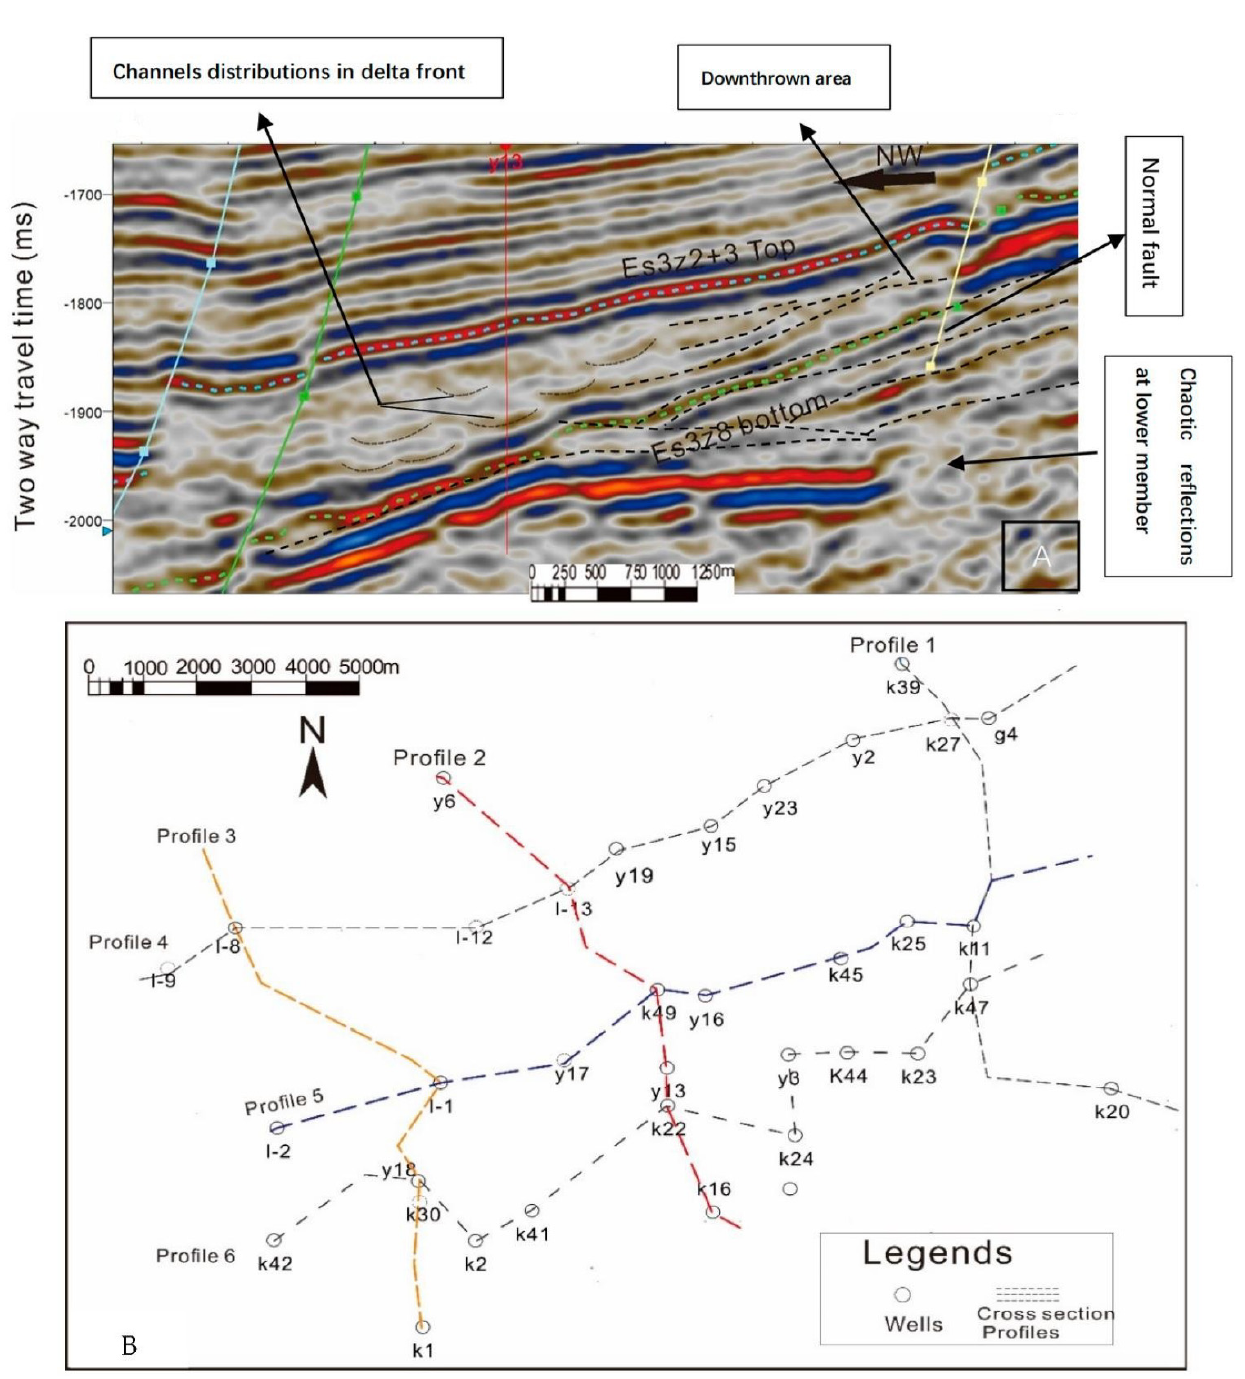
Figure 10. ( A ) Representative seismic section, seismic response of the channels along profile. Prograding reflectors on the deltaic slope belt, top and bottom of sandstone units are visible to be mapped, ( B ) seismic profiles of location area.